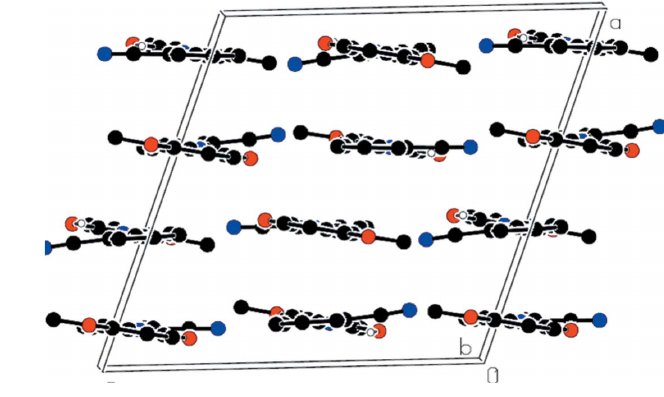
Figure 3 Part of the crystal structure viewed along the b axis to illustrate the (cid:2) – (cid:2) stacking interactions in the crystal. label for c axis not